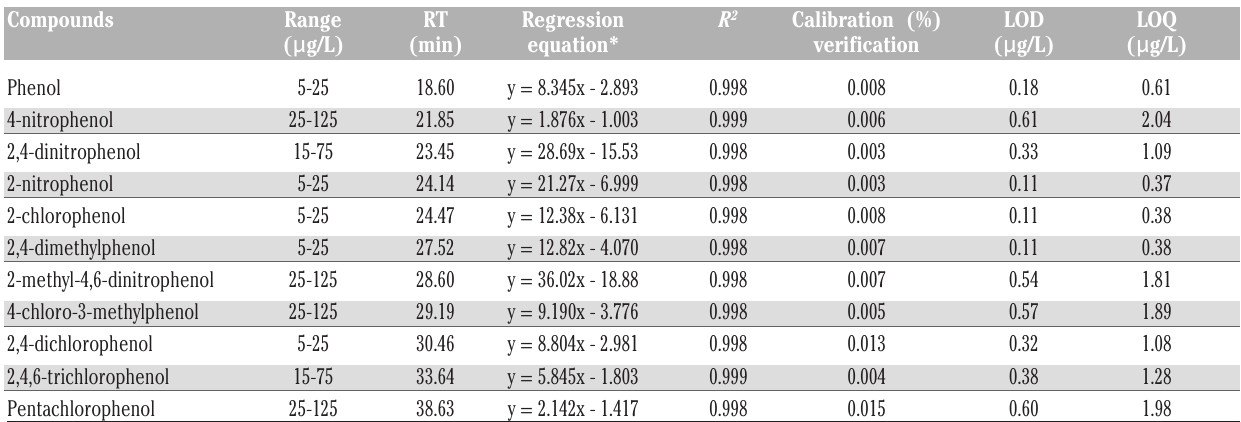
Table 3. Calibration data for linearity, retention times, regression, calibration verification and detection limits. Compounds